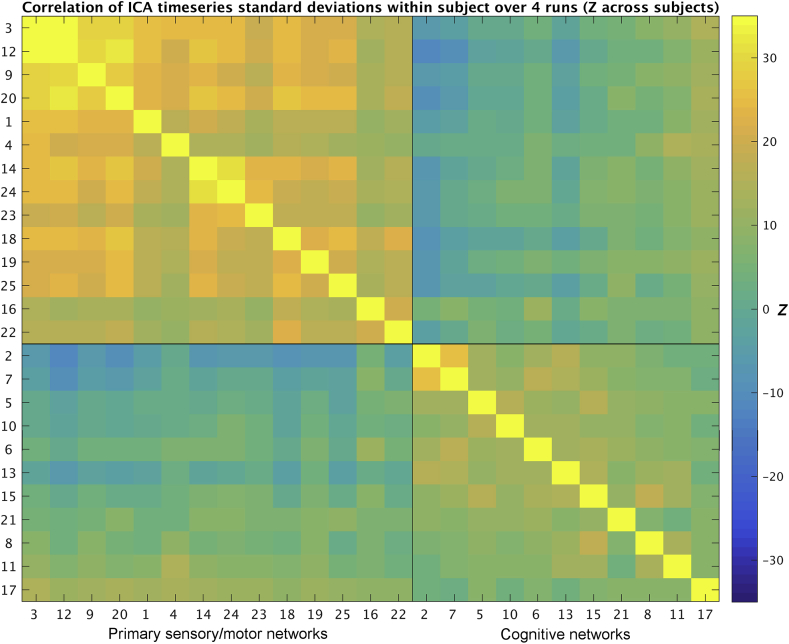
Within-subject replication of correlation matrix of network amplitude. One correlation matrix was estimated for each subject using the 4 different runs, this figure shows Z scores from a one group t-test performed across these subject correlation matrices. Similar results are obtained when splitting the subject data into 8 or 16 (sub-run) blocks rather than into the 4 original runs.